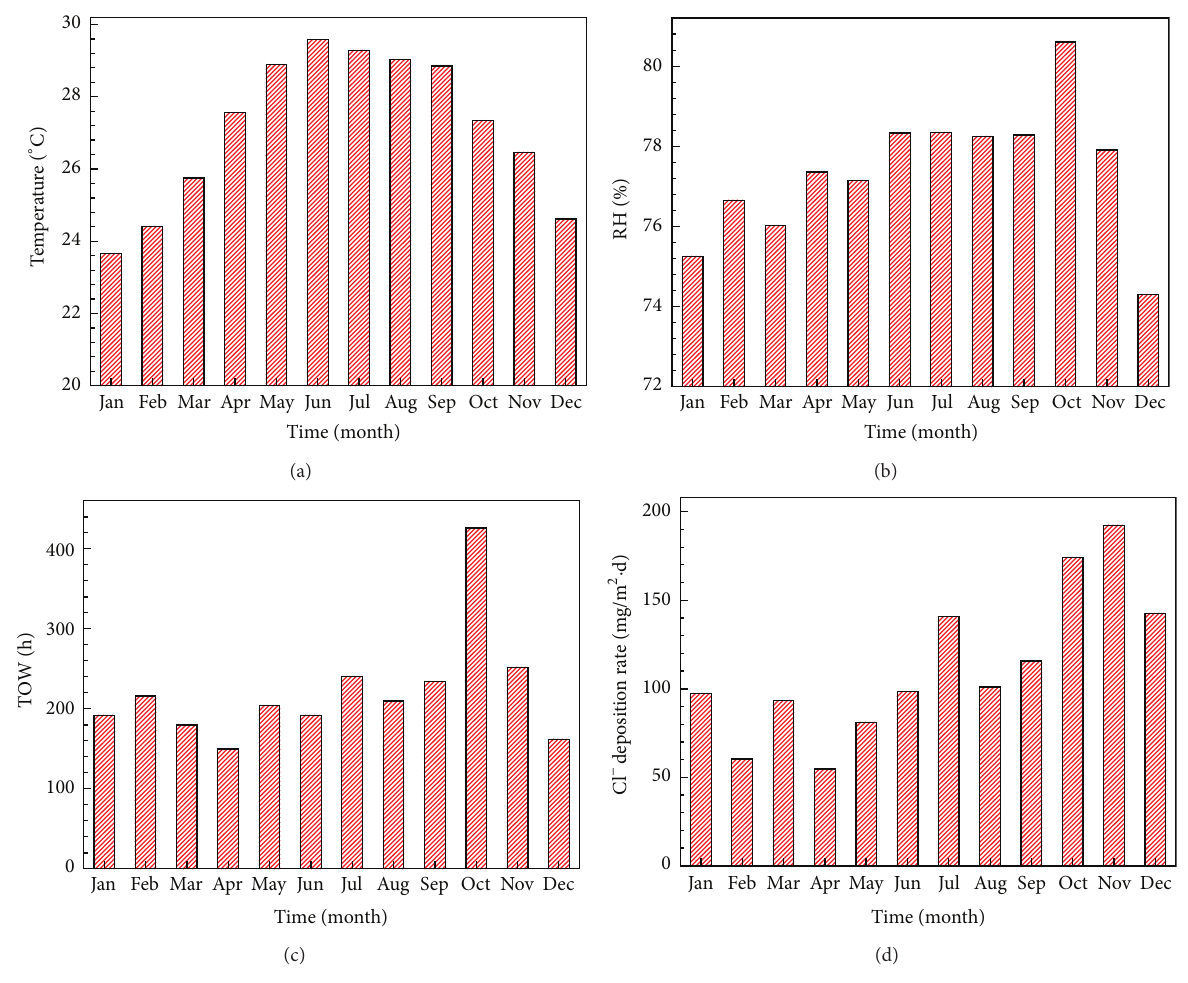
Figure 3: Monthly average temperature (a), RH (b), TOW (c), and Cl − deposition rate (d) during the exposure test.